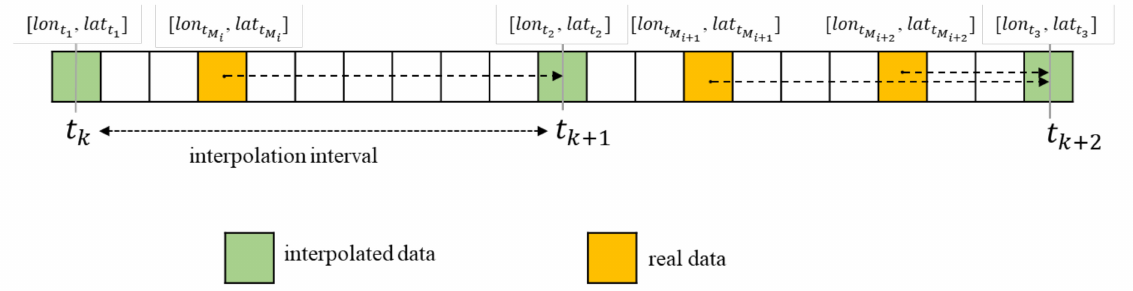
Figure 2. Real positions and the interpolated